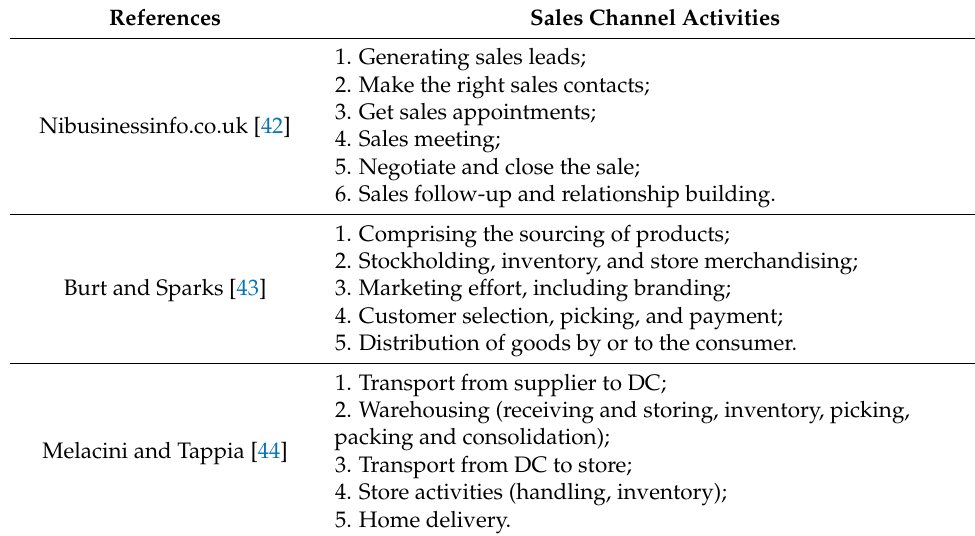
Table 2. Theoretical review of sales channel